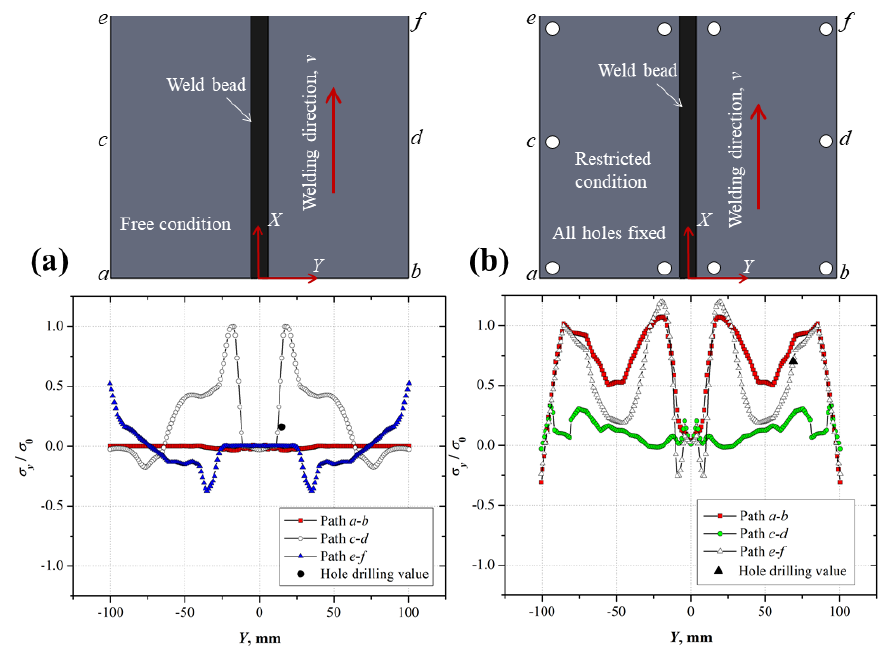
Figure 17. Normalized longitudinal residual stresses ( σ x ) as a function of yield stress ( σ 0 ) of the 3003- H14 aluminum alloy: ( a ) free welding condition and ( b ) restricted condition. The normalized transverse residual stresses ( σ y ) as a function of yield stress ( σ 0 ) for the 3003-H14 aluminum alloy are shown in Figure 18.